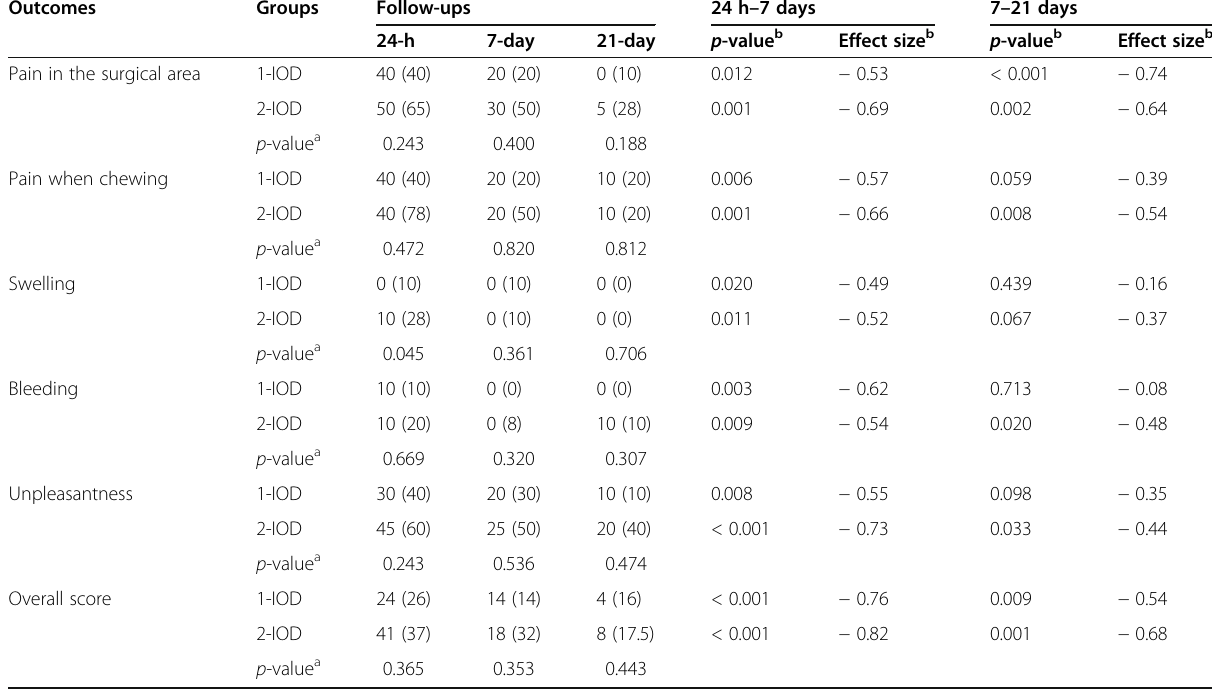
Table 2 Patient perception of postsurgical outcomes according to the follow-up periods and treatment groups. Data are expressed as median (interquartile) values